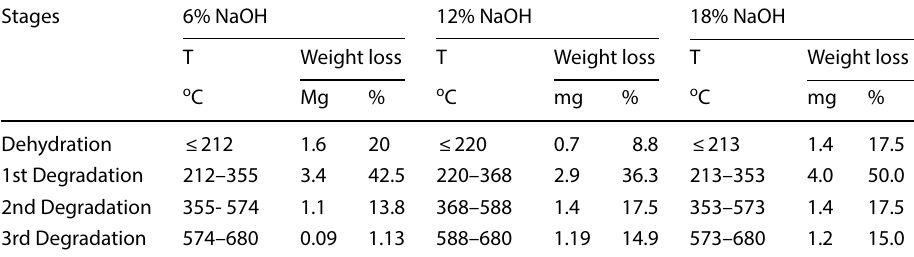
Table 8 Thermal stability data of alkali-treated Y.alpina bamboo fiber with various NaOH concentrations